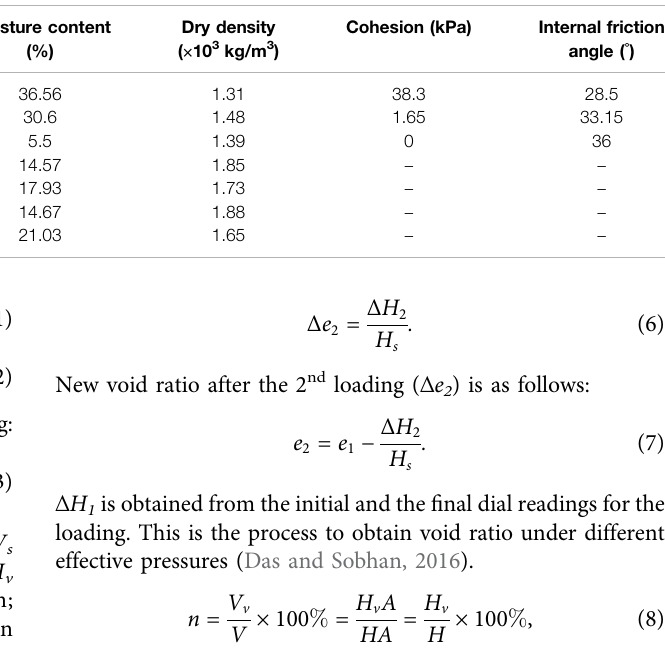
TABLE 2 | Index properties of the laboratory